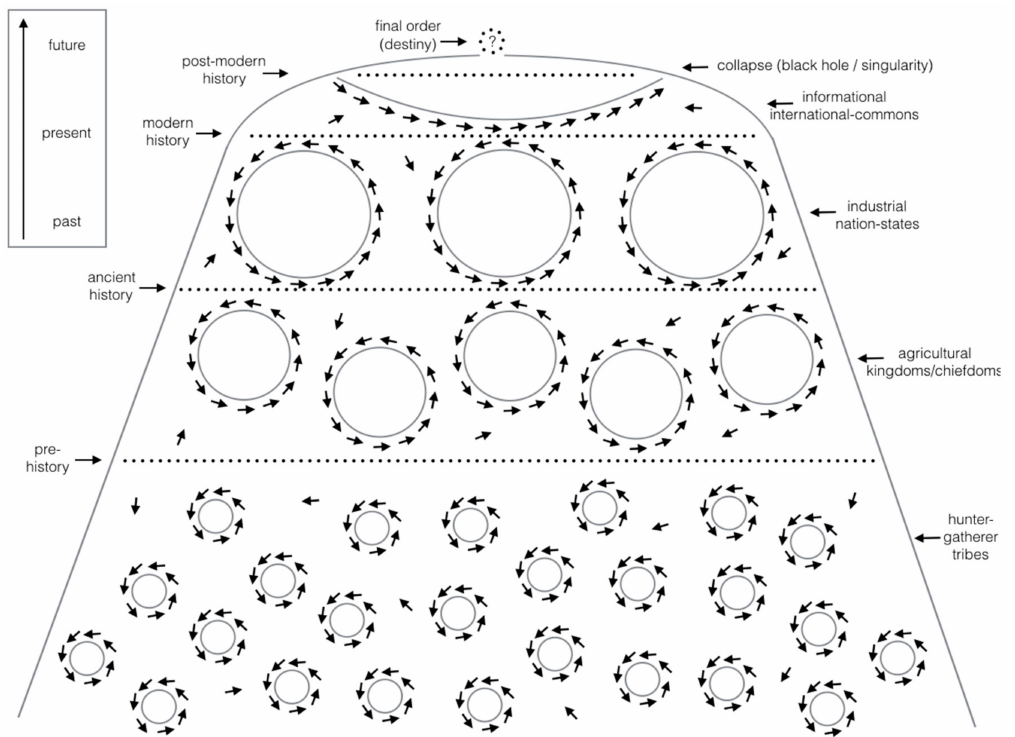
Figure 6. Teleodynamic view of the (local) cosmos, primordial disorder to final order. The above representation attempts to capture the cosmic evolutionary worldview that is characterized